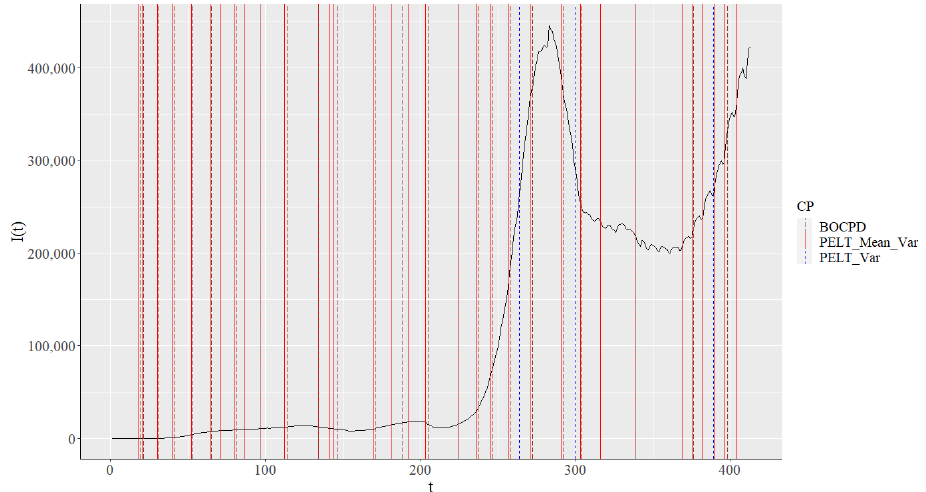
Figure 10. Detection of CPs in COVID-19 infection ( BOCPD ( m ) = 24, PELT _ Mean _ Var ( m ) = 33, PELT _ Var ( m ) = 3).).